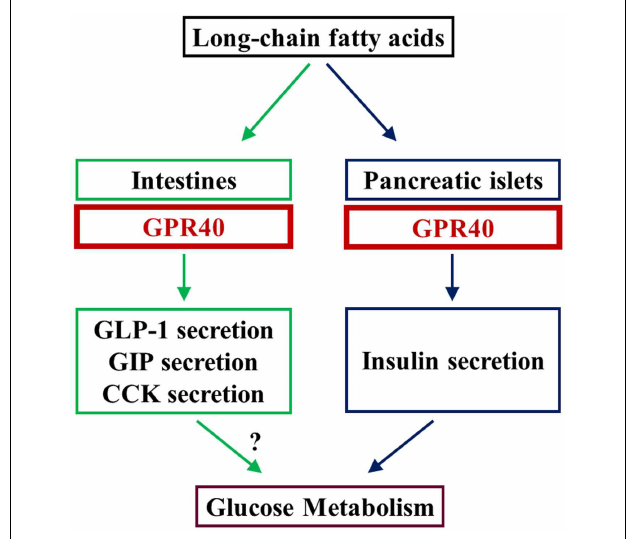
FIGURE 1 | LCFAs augment insulin secretion by stimulating GPR40 in beta cells in the pancreas . GPR40 is also reportedly involved in the positive regulation of secretion of some intestinal hormones. Studies using GPR40 agonists and analyses of beta cell-specific GPR40 transgenic mice indicate that GPR40 is involved in the regulation of glucose metabolism, at least by the augmentation of insulin secretion. Because LCFA-mediated augmentation of insulin secretion is glucose-dependent, GPR40 is thought to be a potential target for novel anti-diabetic drugs with low risk of hypoglycemia.